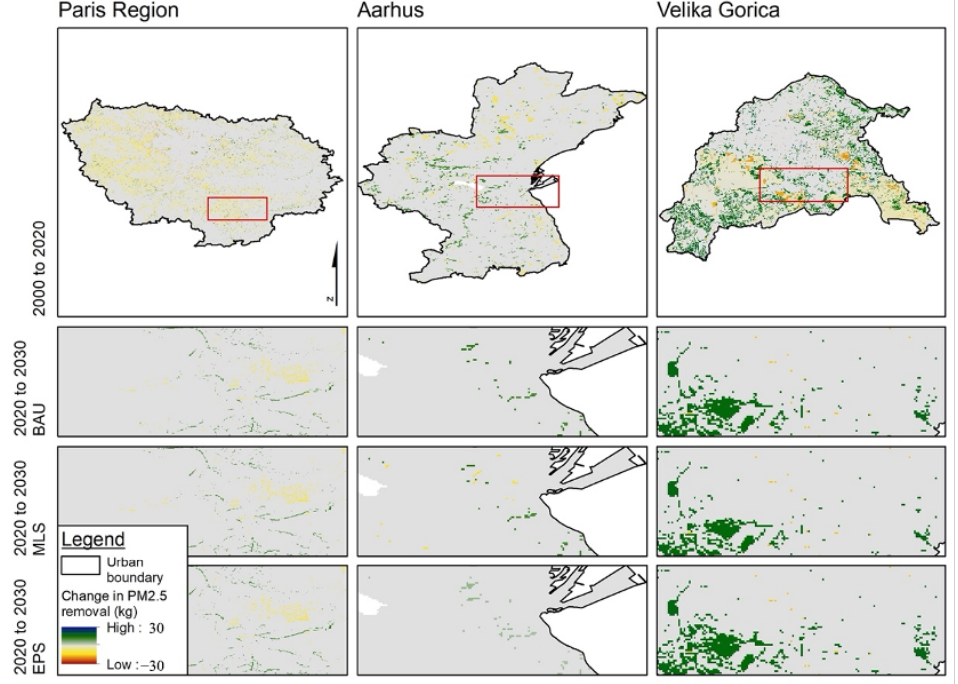
Figure A6. Changes in PM2.5 removal changes for 2000 to 2020 and 2020 to 2030 in Paris region, Aarhus, and Velika Gorica under three different scenarios (BAU, MLS, and EPS). Similar to carbon storage, PM2.5 removal is also greatly affected by land cover changes.